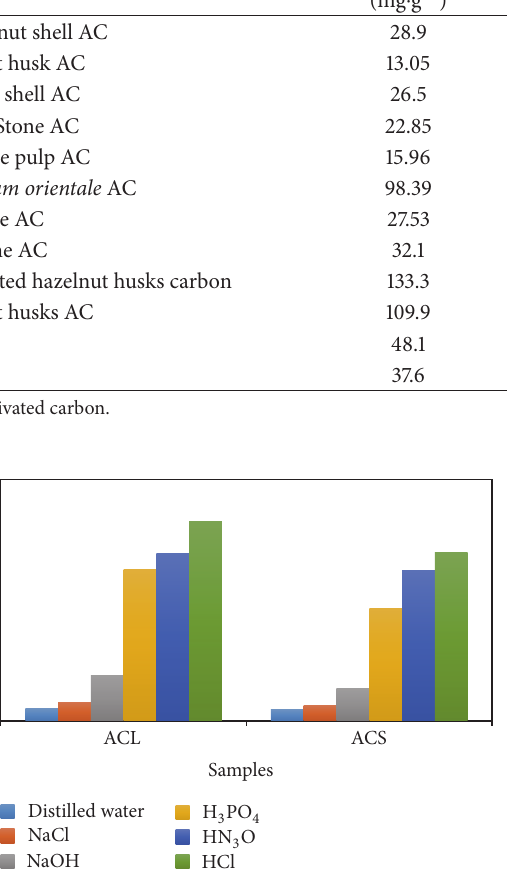
Figure 8: Lead desorption from activated carbon samples using several desorbent chemical agents ( 𝑇 = 25 ∘ C).